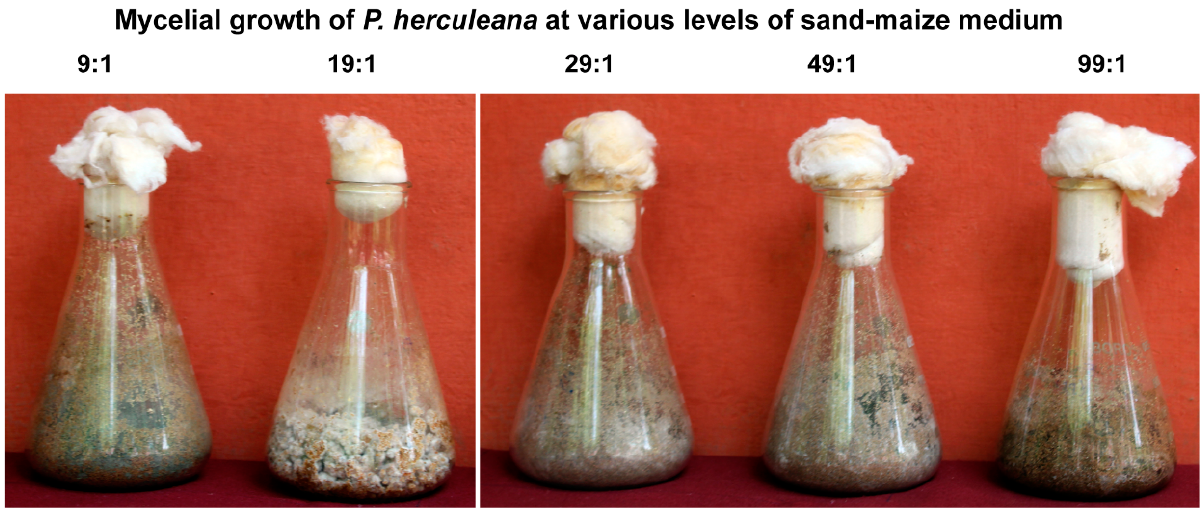
Figure 6. Mycelial growth of Phellorinia herculeana at various levels of sand-maize medium. Sand- maize medium was prepared with different levels of maize powder; inoculated with mycelial disc of P. herculeana and mycelial growth was recorded.